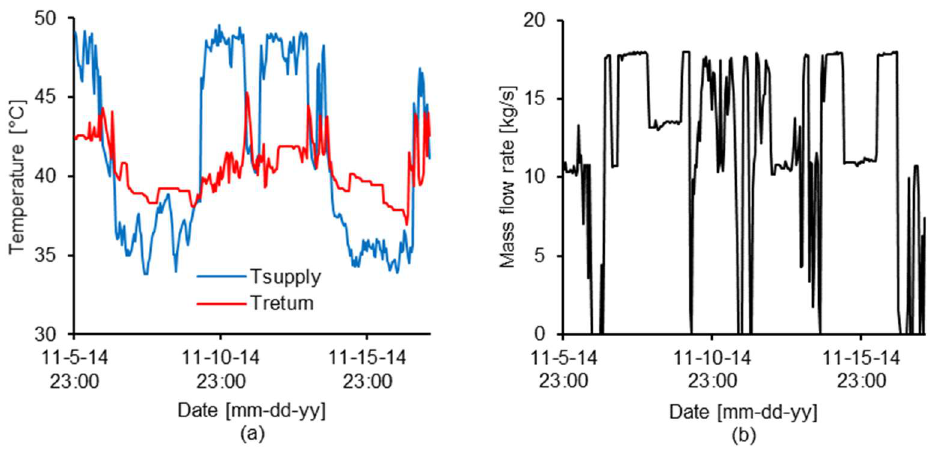
Figure 3. Schematic of the borehole heat exchanger. The open borehole heat exchanger design means that the heat carrier, being a mixture of groundwater and externally added water, has direct contact with the borehole wall.